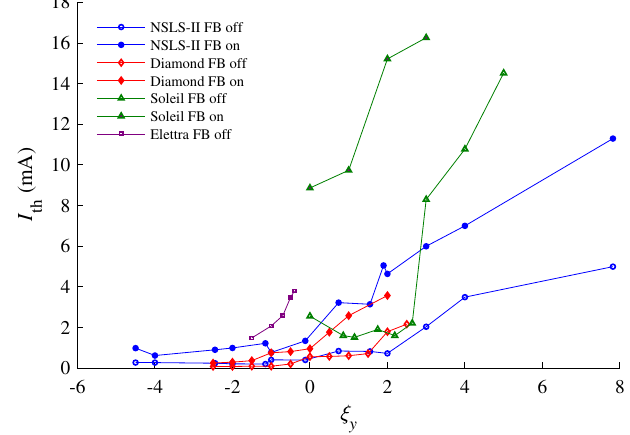
FIG. 2. Measured single-bunch threshold current as a function of chromaticity, with and without